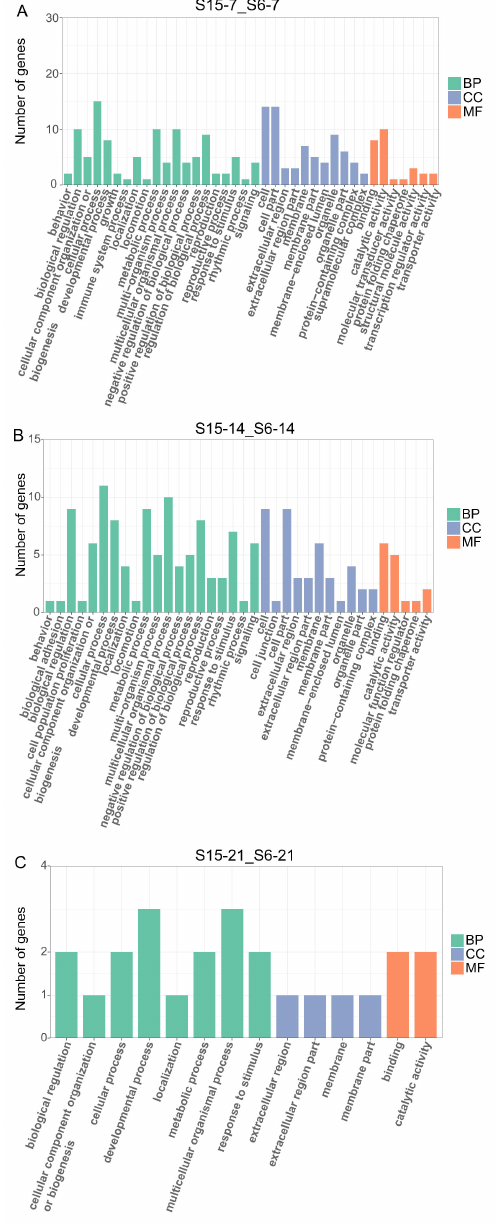
Figure 3. Enriched GO terms for DEGs in M.rosenbergii post-larvae under hypotonic stress at different development stages. Note: ( A ): DEGs of comparison group S15-7_S6-7 enriched GO terms; ( B ):